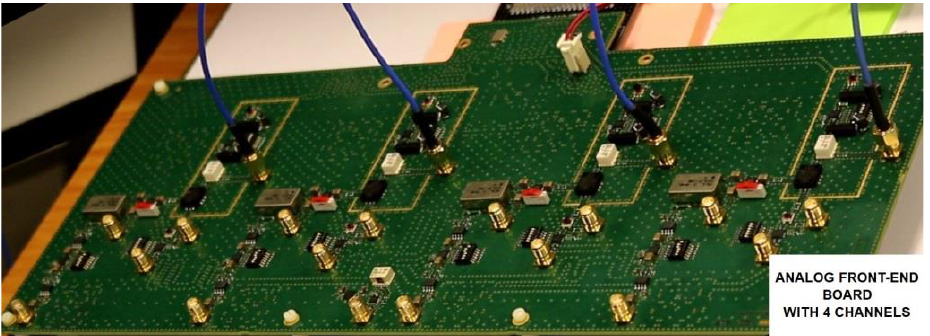
Figure 8. Photo of our analog front-end board.